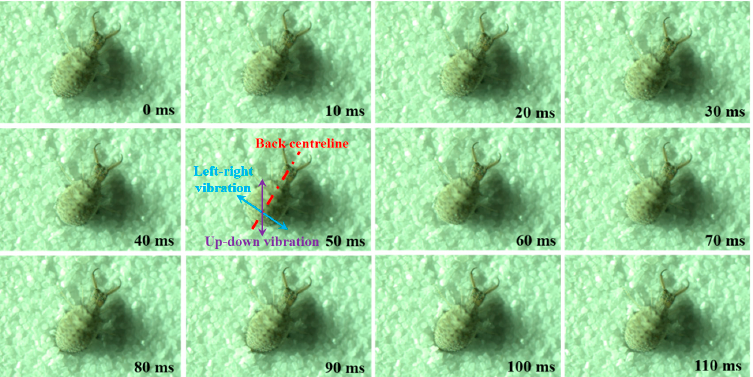
Figure 2. The whole process of soil digging by the antlion.